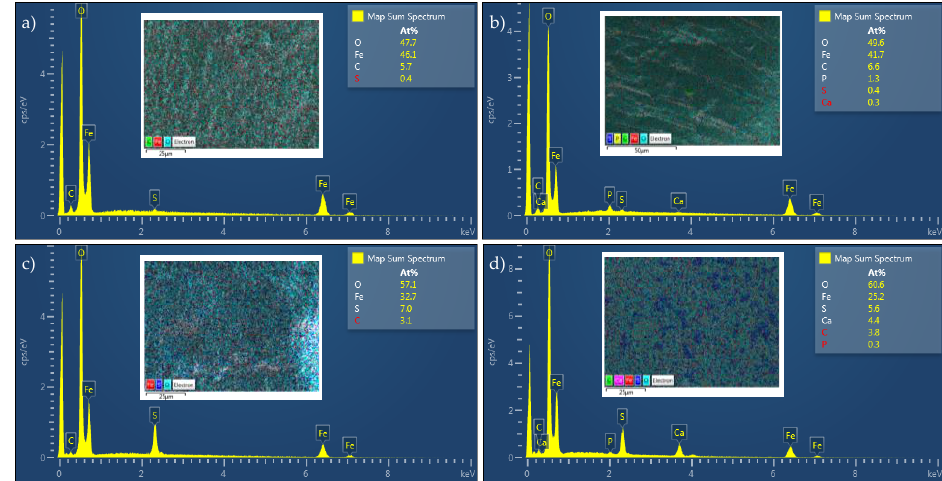
Figure 8. EDX analysis of initial ( a , b ) and final ( c , d ) Fe 2 O 3 and goethite catalysts, respectively.